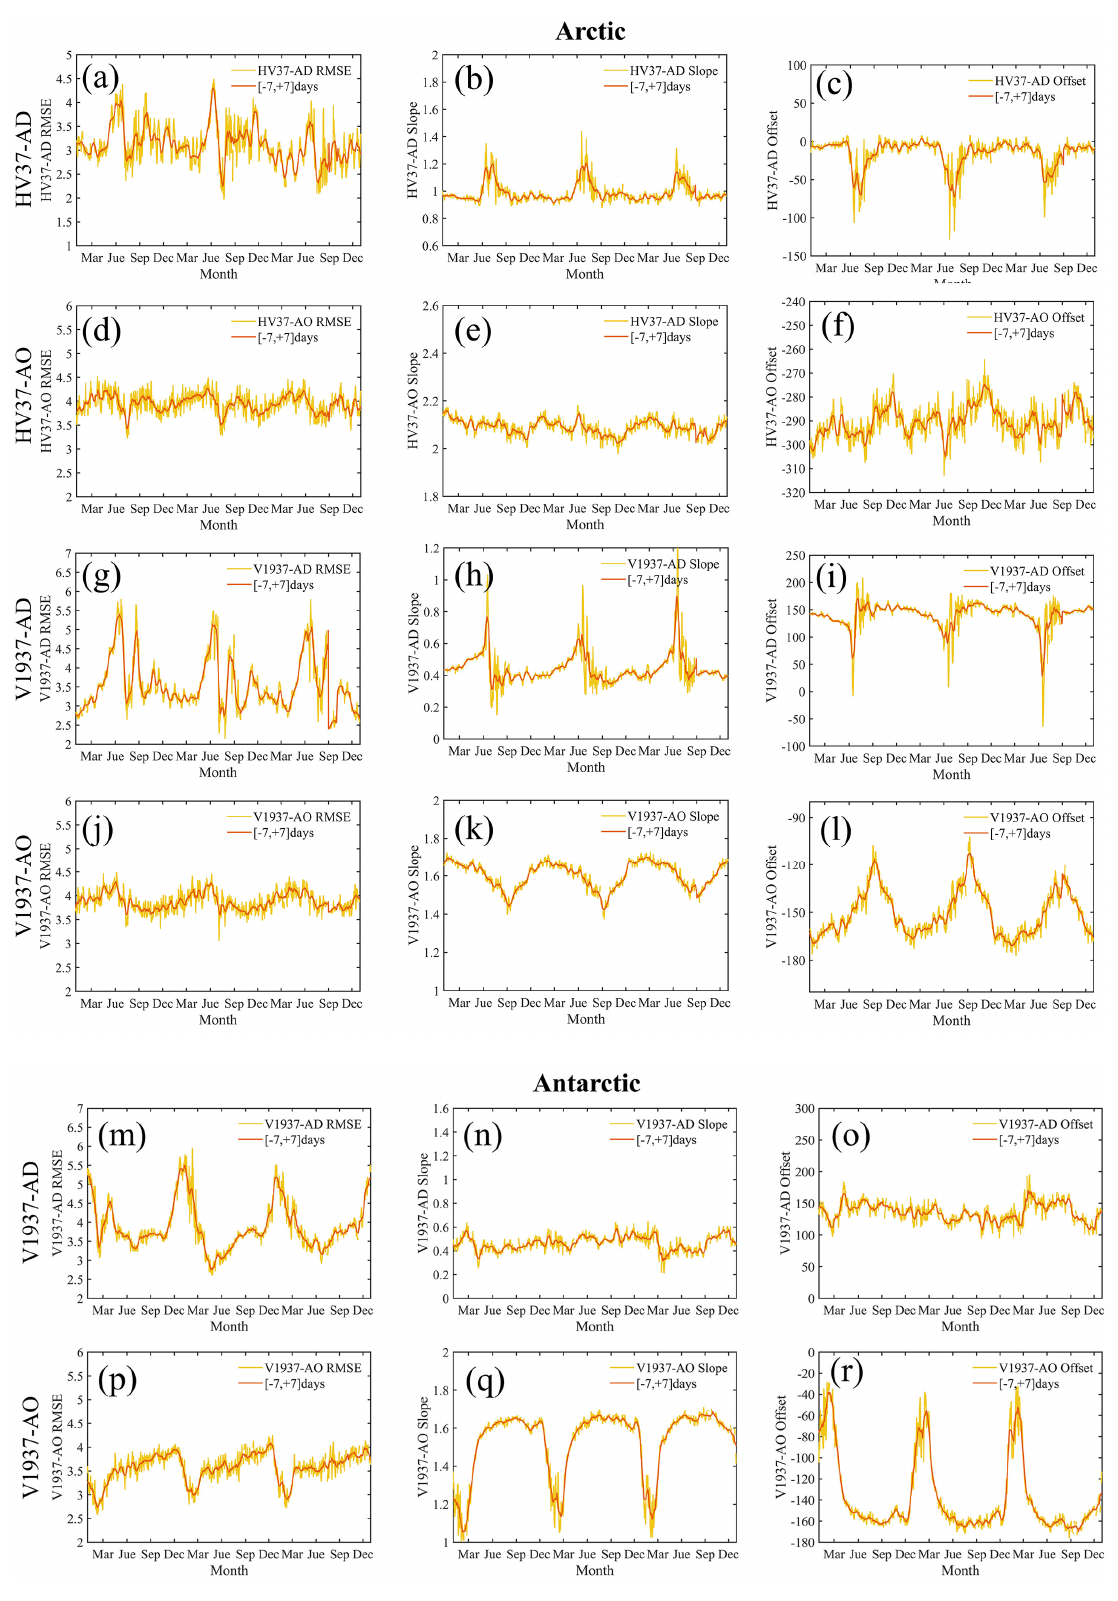
Figure 6. The linear regression parameters for SIC retrieval. The ( a – l ) diagrams indicate the Arctic, and the ( m – r ) diagrams indicate the Antarctic. The first column represents the RMSE of the respective linear regression equation; the second column represents the slope; and the third column represents the intercept.